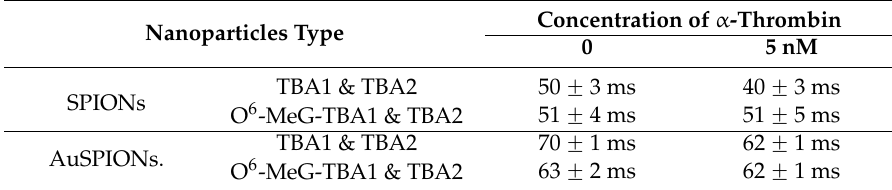
Table 3. T2 relaxation times in the absence or presence of α -thrombin. SPIONs were measured at 1/1000 (2.4 µ g Fe/mL) and the AuSPIONs 1/1 (2.4 mg Fe/mL). These results represent the average of at least three independent